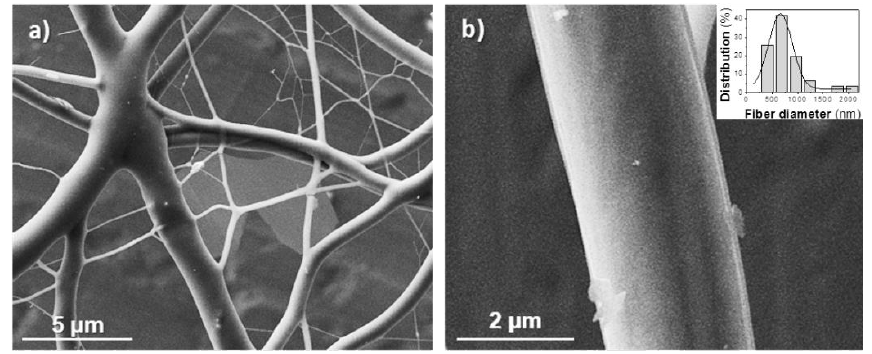
Figure 4. SEM micrographs of (poly(glc-6-glc 6) electrospun samples taken at low ( a ) and high magnification ( b ). Fibers were obtained under the following concentration, flow rate, voltage and needle-collector distance conditions: 50% ( w / v ), 0.5 mL/h, 15 kV, 20 cm. The inset shows the diameter distribution of the thicker fiber population.